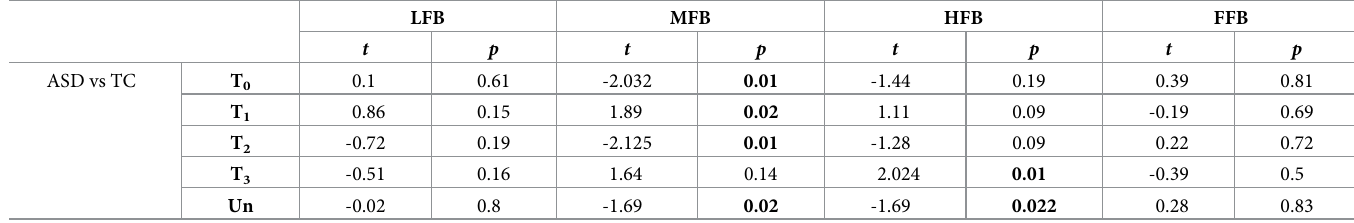
Table 4. Statistical comparison between ASDs and TCs for metrics of triadic interactions. The t and p are statistical and corrected probability values, respectively. LFB MFB HFB FFB p p p